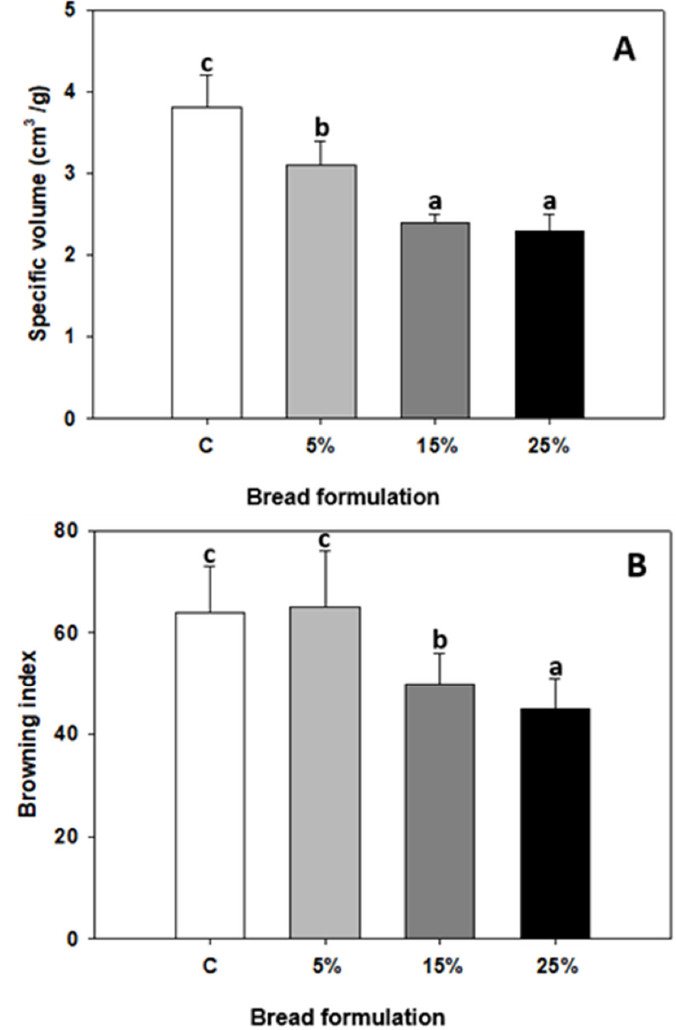
Figure 2. Baking quality parameters: ( A ) specific volume of bread and ( B ) Browning Index. Breads: wheat flour (control: C) and blends of wheat flour and oat flour at 5, 15, and 25%. Different letters in the same figure indicate significant differences ( p < 0.05).